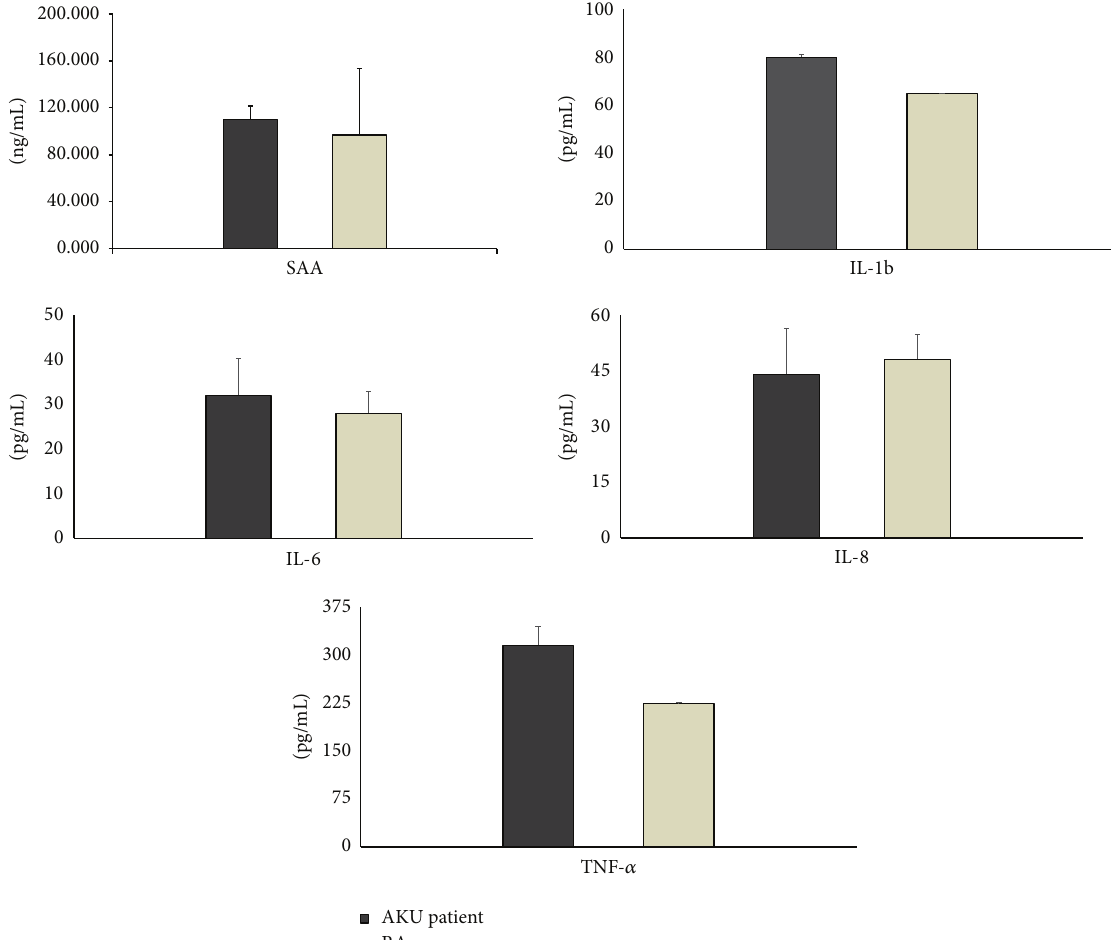
Figure 9: Evaluation of SAA and the profile of proinflammatory cytokines in the plasma from AKU patient. SAA plasma levels were evaluated by ELISA while cytokines were assayed by Bioplex. A comparison with levels found in a pool of plasma from 15 rheumatoid arthritis (RA) patients is also reported. Experiments were performed in triplicate; data are presented as average values ± standard